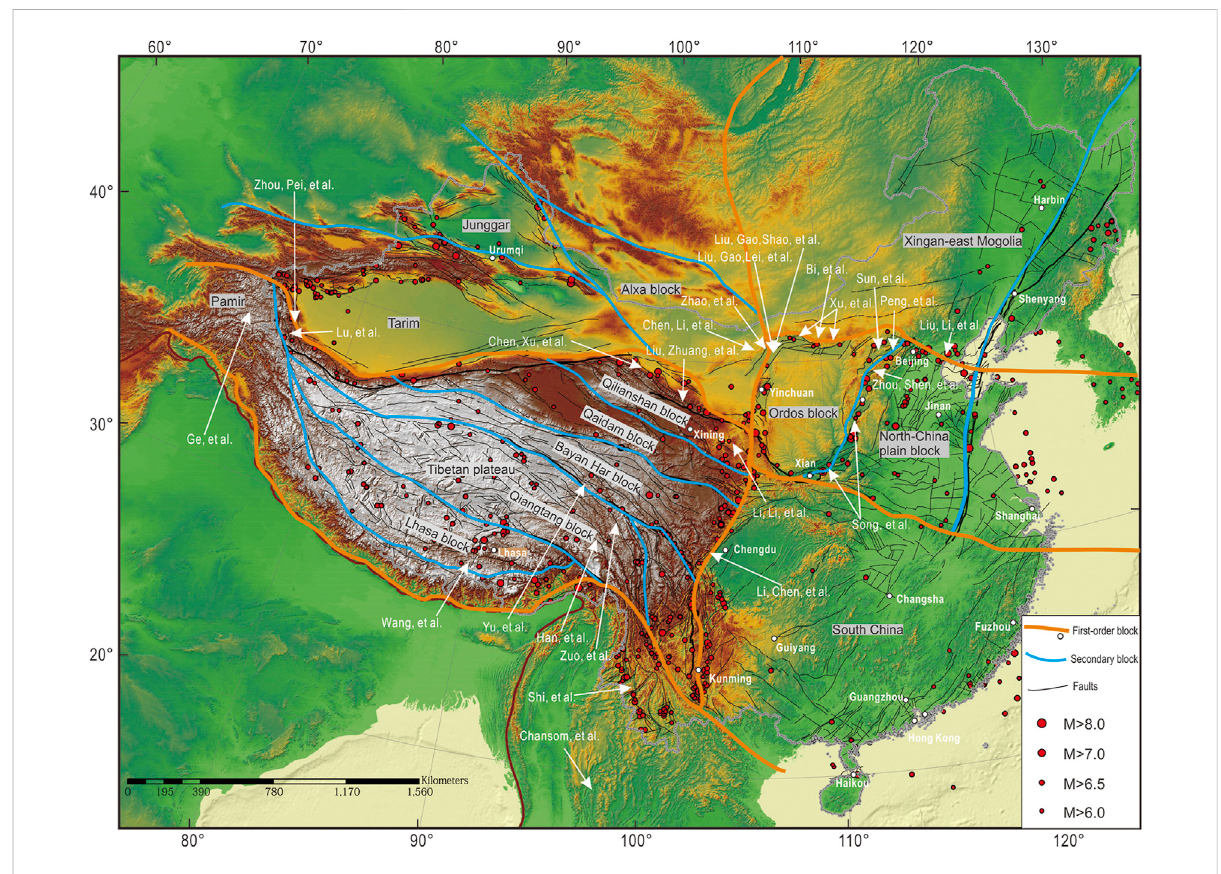
west. The determined left-lateral slip-rate of 6.3 ± 1.9 mm/yr in the Holocene along the fault (Yu et al.) is very close to the estimated average slip rate for the Xianshuihe fault. Surface ruptures with a length of ~100 km of the 1,738 earthquake have been discovered along the Dangjiang segment (Yu et al.), which demonstrates that the individual segments of the faults bounding the southern boundary of the Bayan Har block are all able to produce large earthquakes. The eastern margin of the Tibetan plateau is bounded by the Longmen Shan fault zone that is also the eastern boundary of the Bayan Har block and